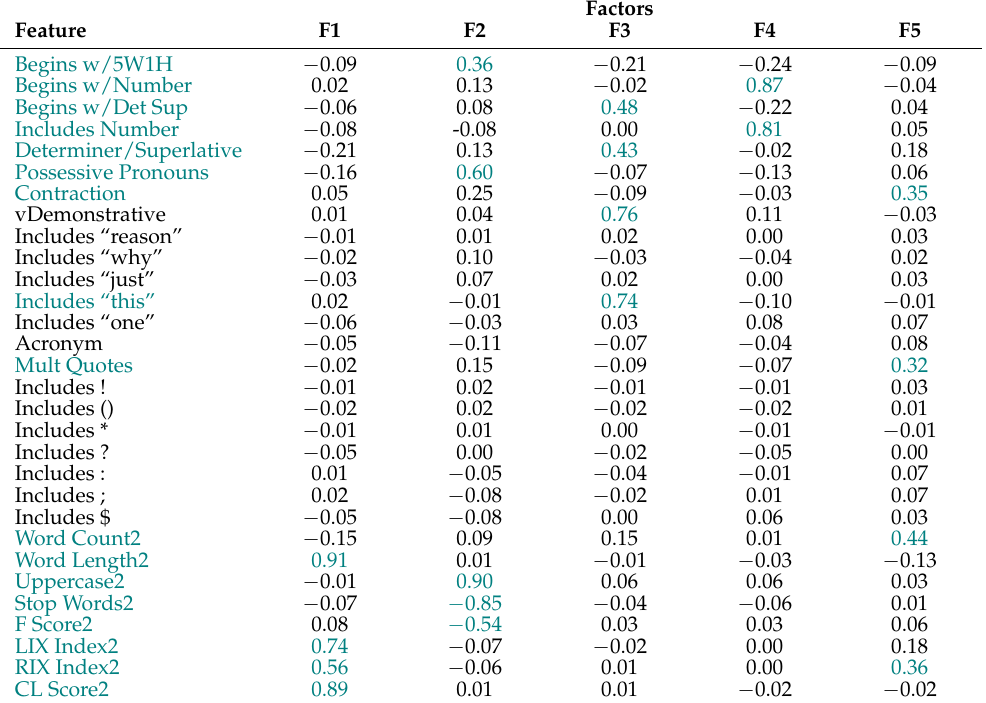
Table 6. Five Factor Loadings Matrix.